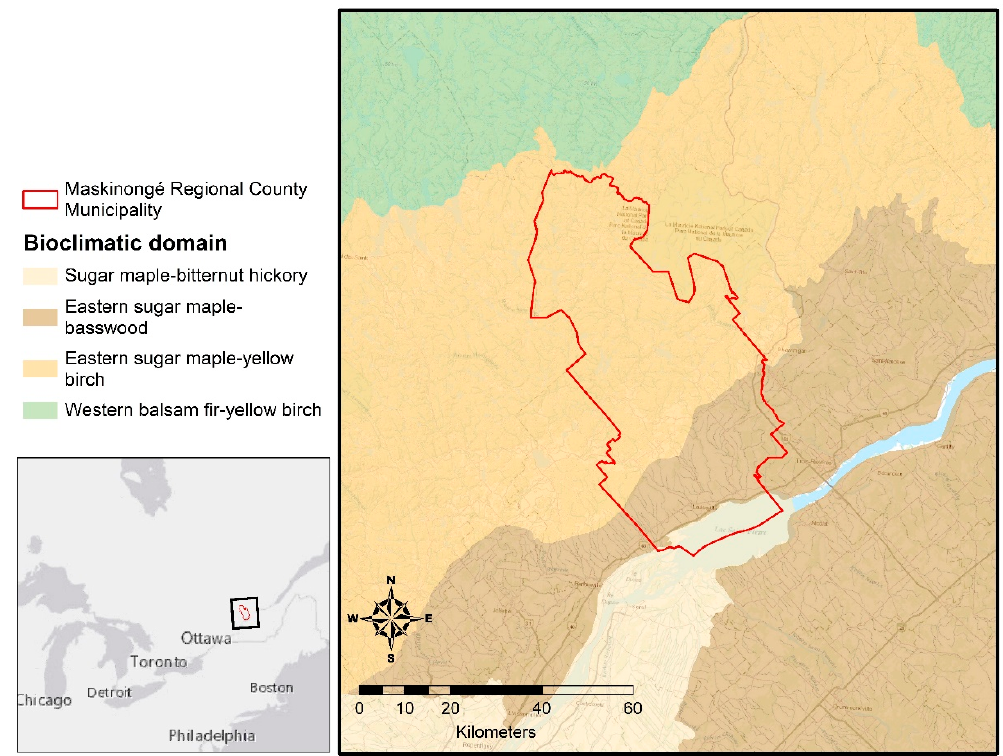
Figure 1. Location of the study area according to Quebec’s bioclimatic domains.